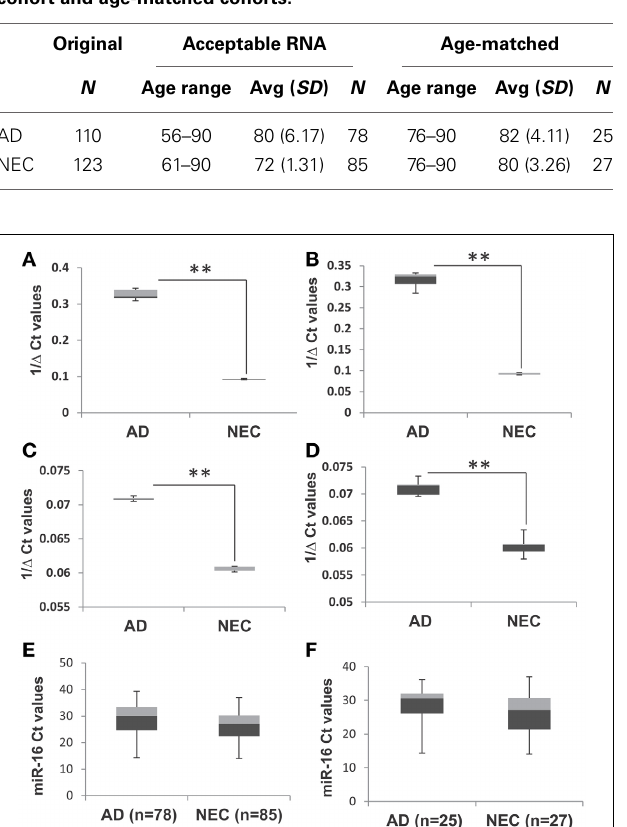
Table 1 | Plasma specimens from the entire cohorts of Alzheimer’s disease (AD) and normal elderly control (NEC) individuals, selected after RNA quality control, with age range, average age with standard deviation (SD), and sample size (N) for acceptable RNA in the entire cohort and age-matched cohorts.